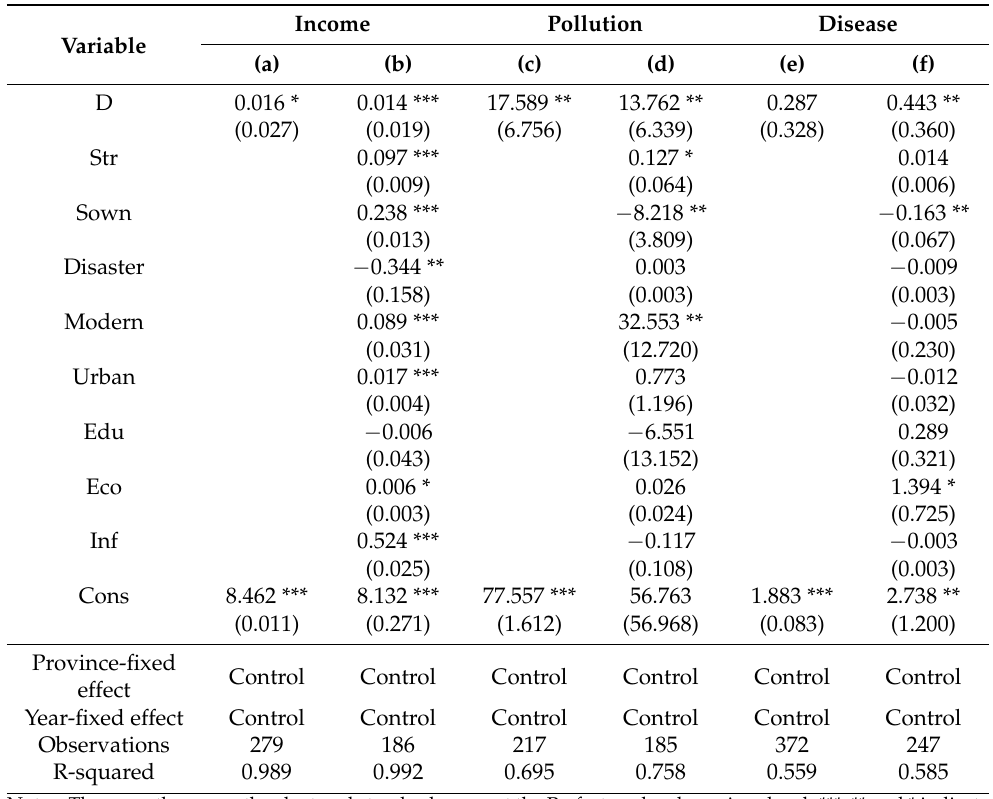
Table 4. Benchmark